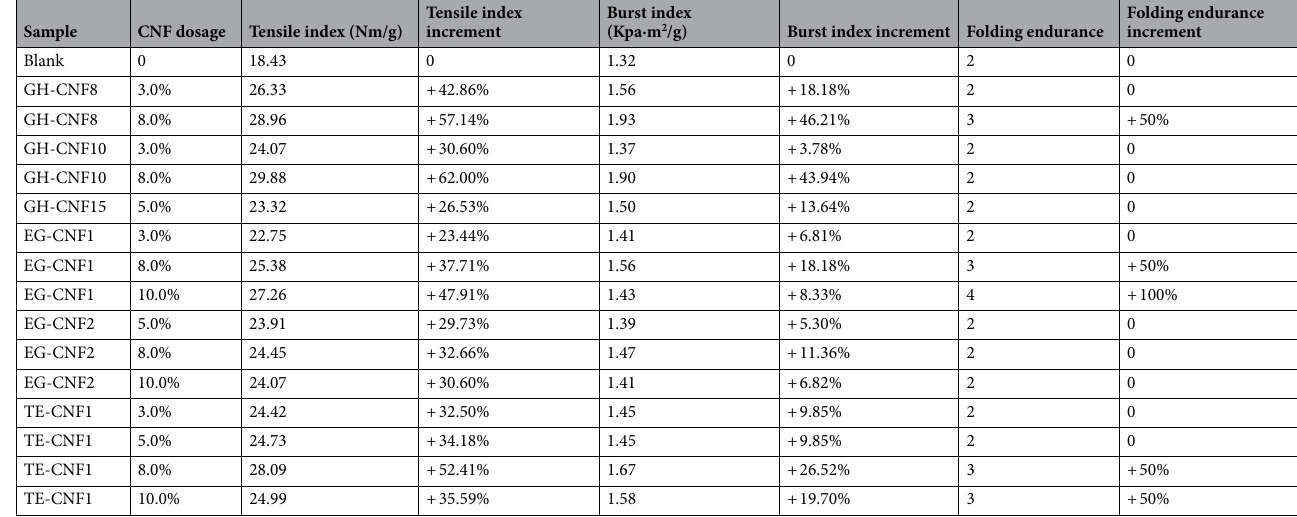
Table 4. Change in mechanical strength of papers from recycled pulp B strengthened by various kinds of CNFs at different dosages. (For each value, a total number of 30 parallel experiments were done and the numbers shown were mean